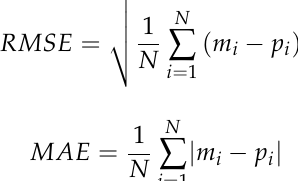
Figure 6. Comparisons of 3rd ( a ) and 5th ( b ) harmonic current estimation by proposed method and Norton-based methods.